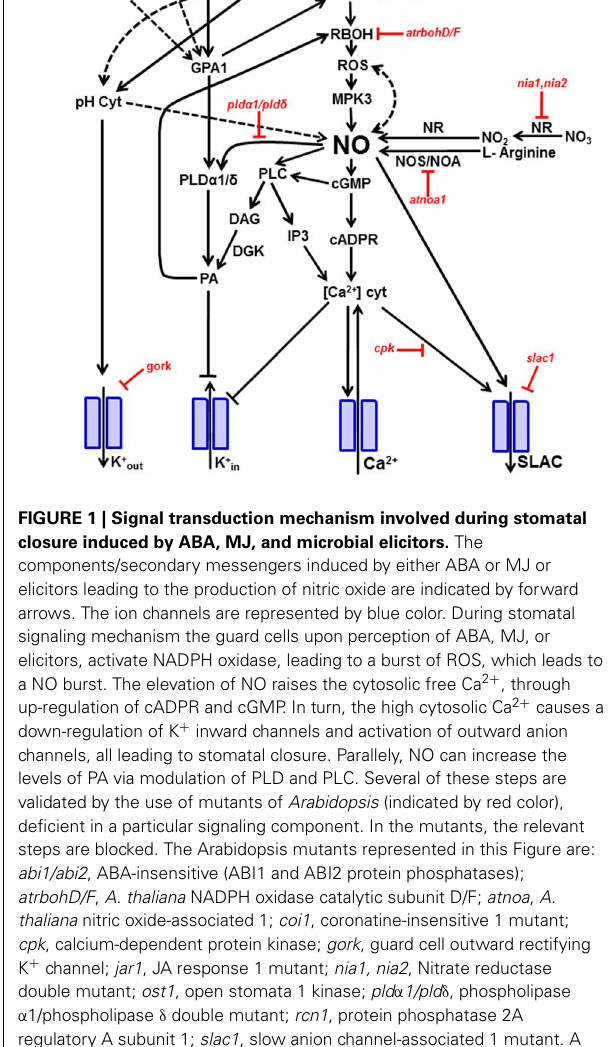
and PA, and to some extent, with pH. For e.g., Ca 2 +